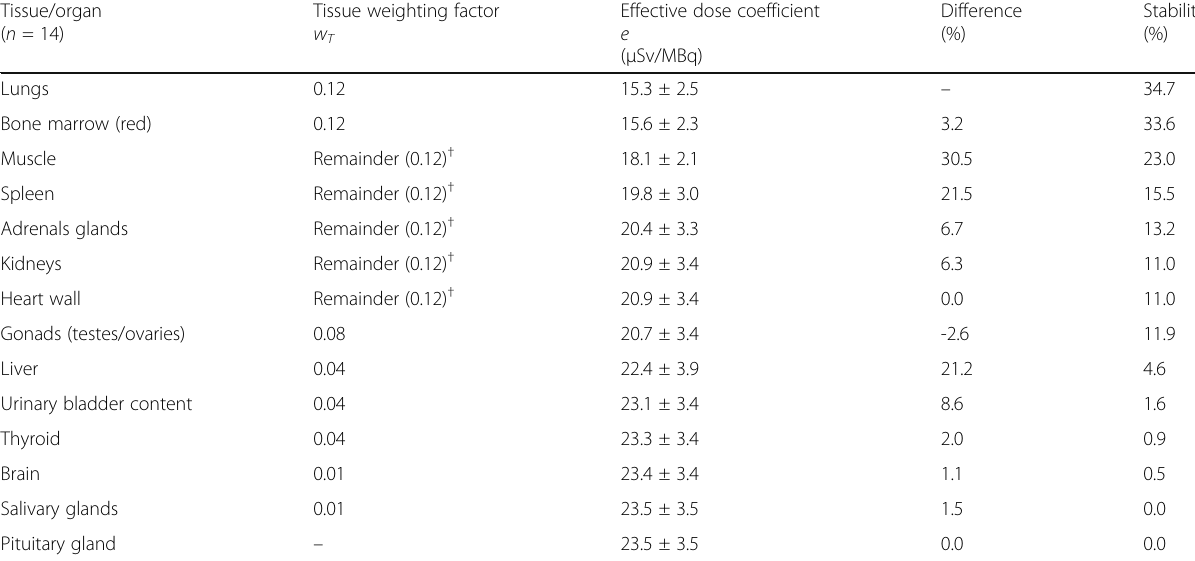
† The order of the remainder organs/tissues were according to the impact shown in Table 3